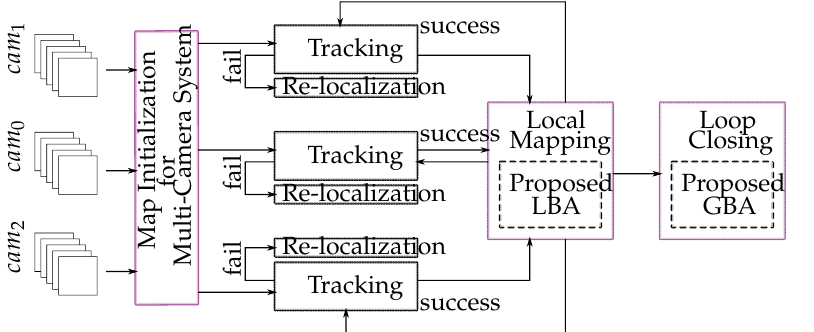
Figure 2. Block diagram of the proposed multi-camera SLAM